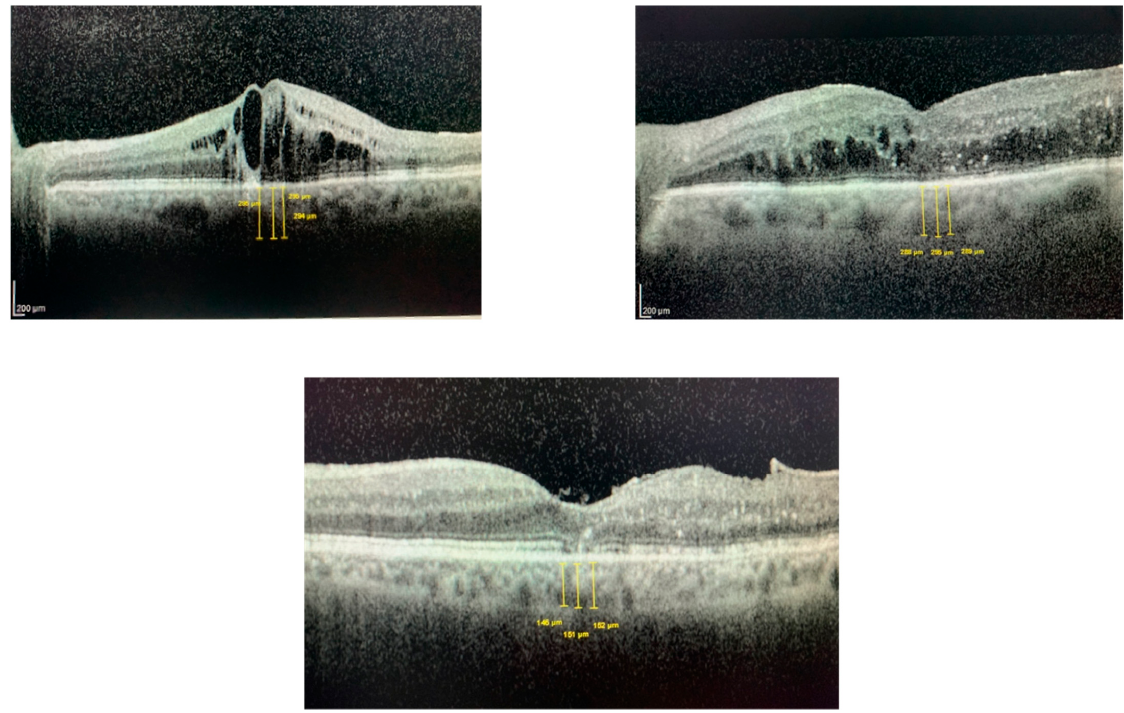
Figure 1. Three examples of manual measurements of the subfoveal choroidal thickness (SFCT) measurements performed with the OCT. Images from the